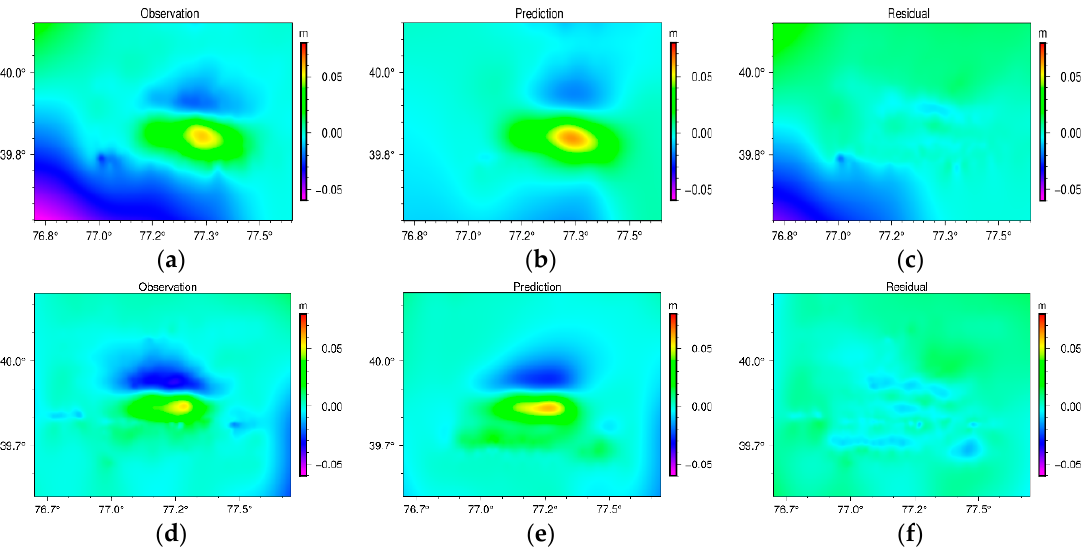
Figure 5. Coseismic displacement (negative values indicate range displacement away from the satellite) and model for the slip distribution inversion of the 2020 Jiashi earthquake. ( a – c ) are the measurement, model, and residual derived from the descending track. ( d – f ) are the measurement, model, and residual derived from the ascending track.